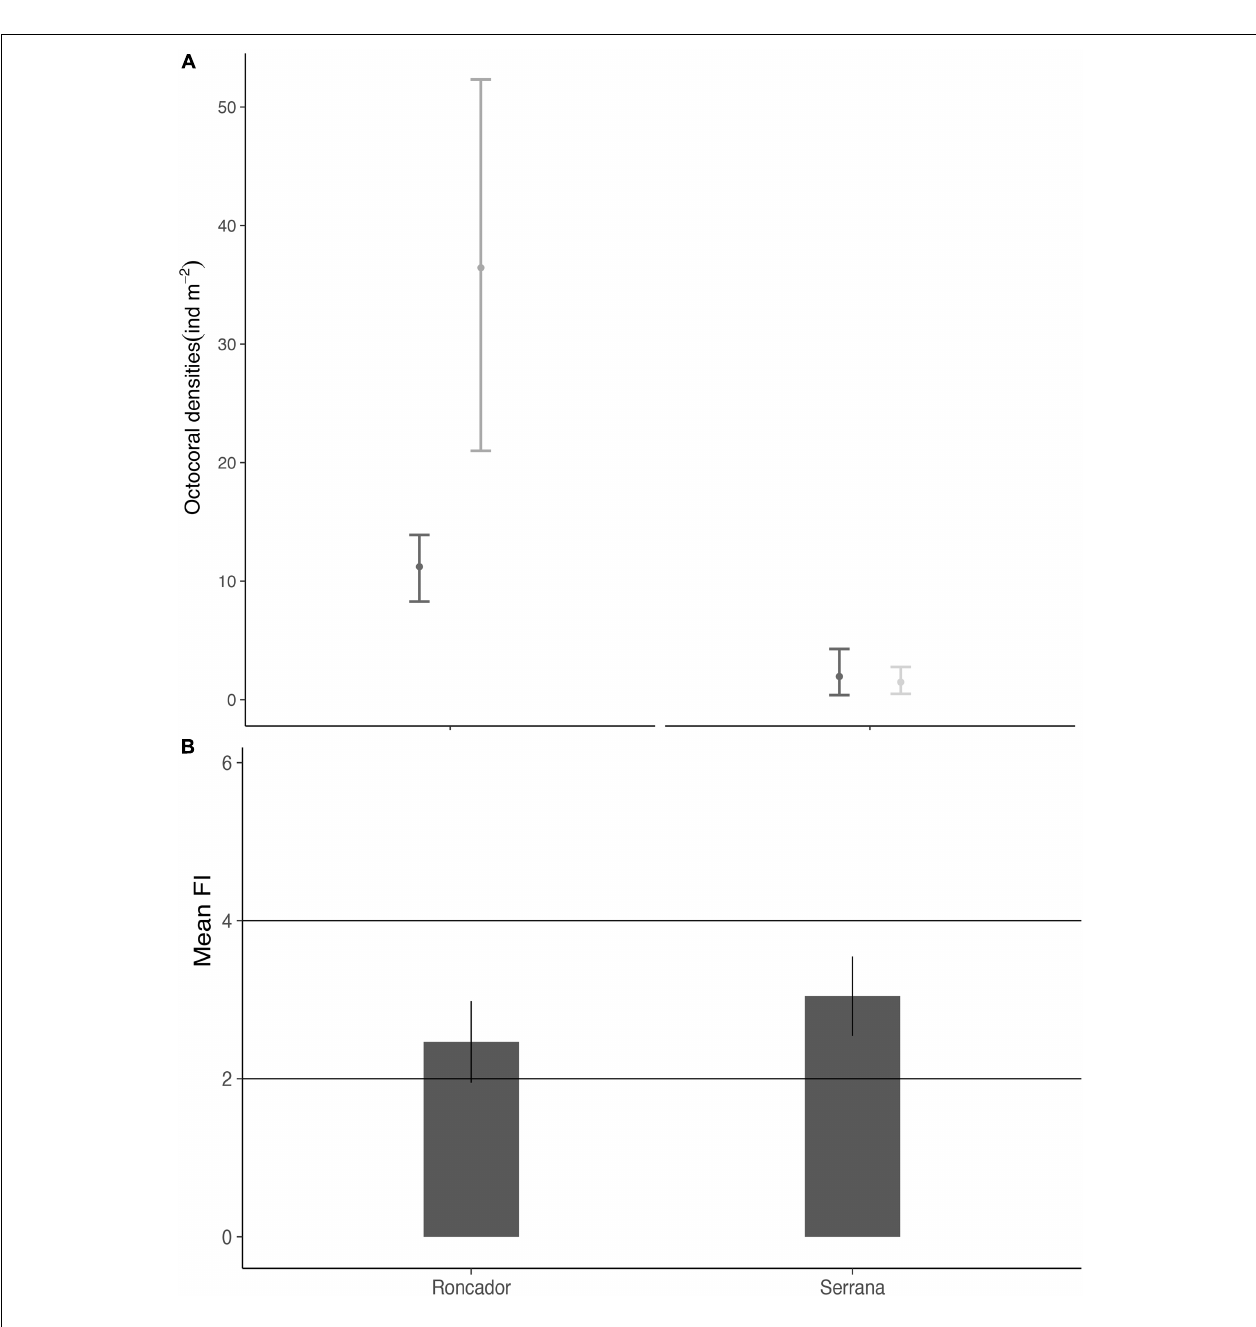
FIGURE 5 | Octocoral and Benthic foraminifera abundance. (A) Octocoral densities (ind m - 2 ) means with 95% CI in Roncador and Serrana during 2003 and 2015/2016. (B) The average FI ± SD for Roncador 2015 and Serrana 2016. Horizontal lines represent critical point for analysis (Hallock et al., 2003)].